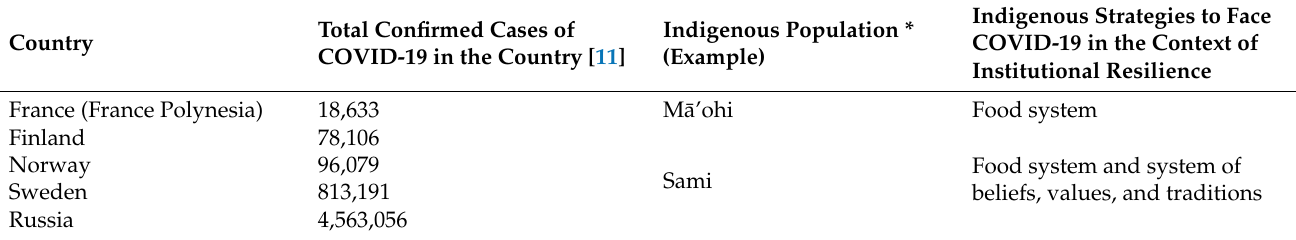
Table 4. European countries (continent) with indigenous populations and their strategies deployed in the face of COVID-19. Total Confirmed Cases of Country COVID-19 in the Country [11]